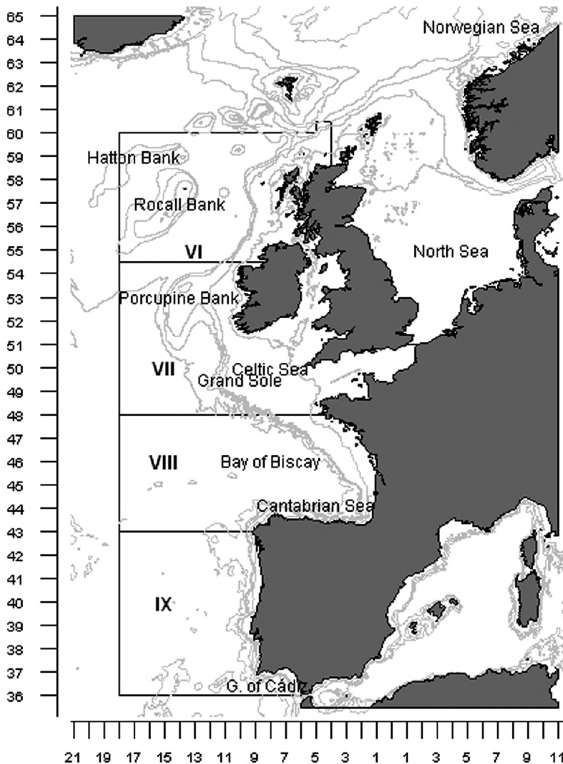
Fig . 1. – Main fishing grounds in the northeast Atlantic for the fleet involved in the study (VI-IX ICES